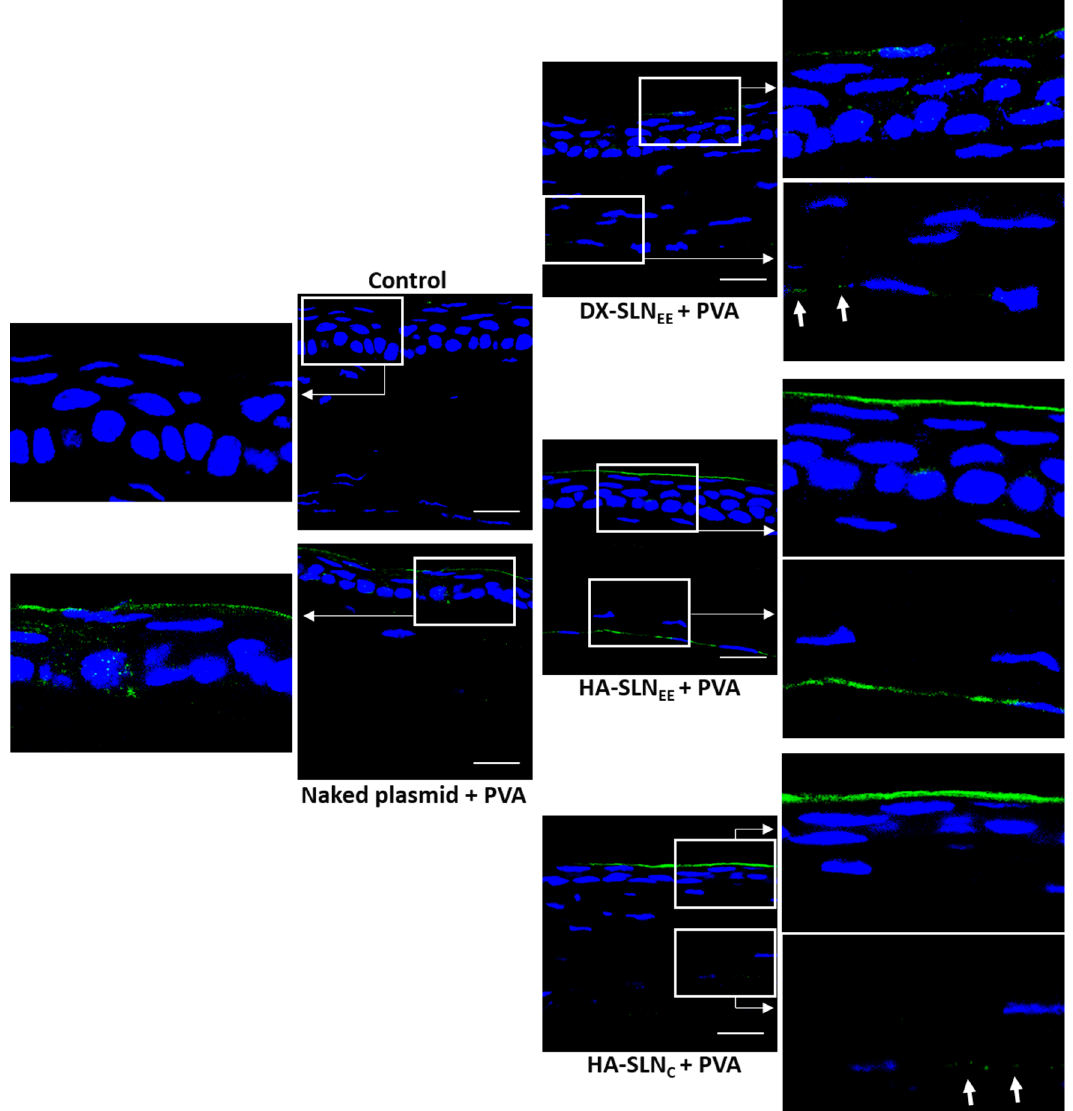
Figure 7. Corneal transfection in vivo in wild type mice treated with naked plasmid and vectors bearing the plasmid pUNO1-hIL10 with PVA (60 × ). Blue: nuclei stained with DAPI. Green: IL-10. Scale bar: 20 µ m. For each sample, a global image of the corresponding corneal section and a magnification of the epithelium and endothelium areas have been included. Arrows in magnifications indicate detection of IL-10. DX: dextran; SLN: solid lipid nanoparticle; PVA: polyvinyl alcohol; HA: hyaluronic acid.